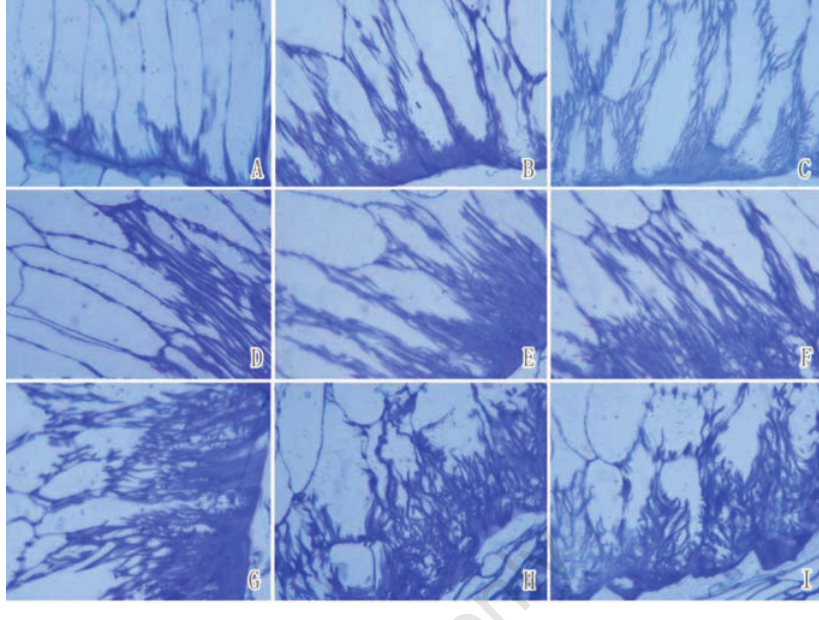
Figure 3. Sorghum endosperm transfer cells at different days after pollination (DAP) under the light microscope (magnification: 1000X, cells cut longitudinally). A, 6 DAP;